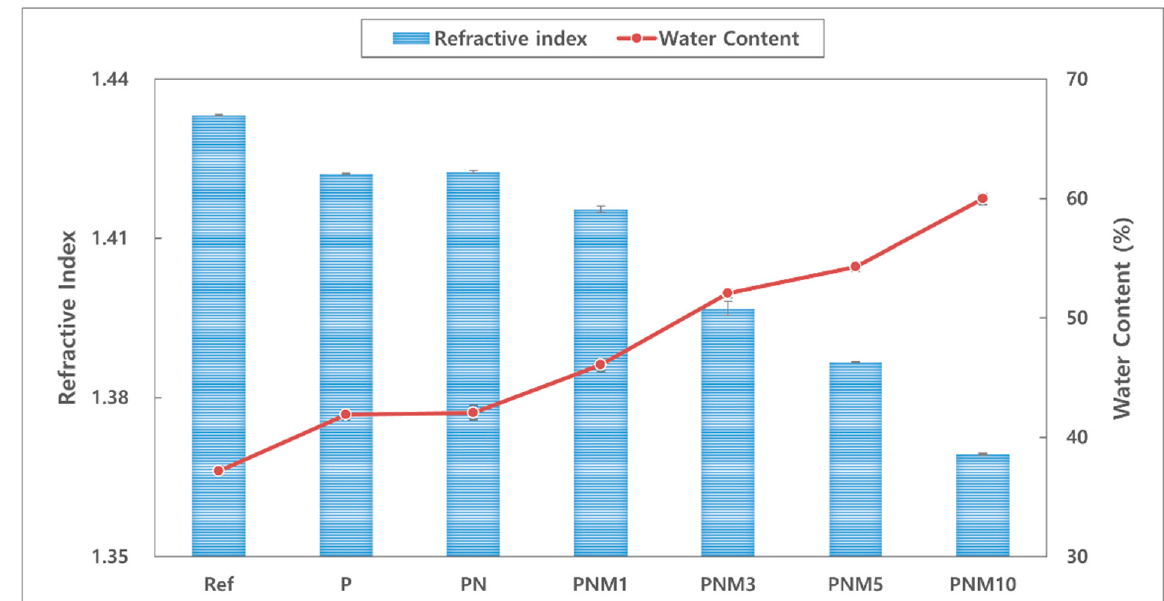
Figure 1. Change of refractive index and water content of samples.